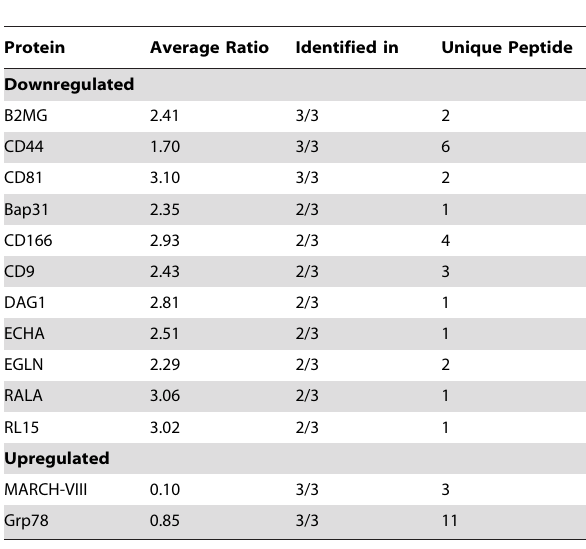
Table 1. Proteins displaying a differential abundance following MARCH-VIII expression.